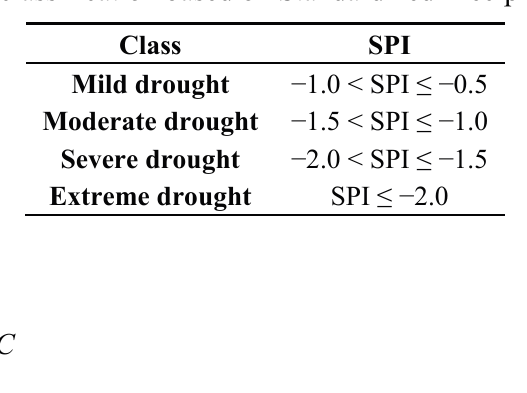
Table 2. Drought classification based on Standardized Precipitation Index